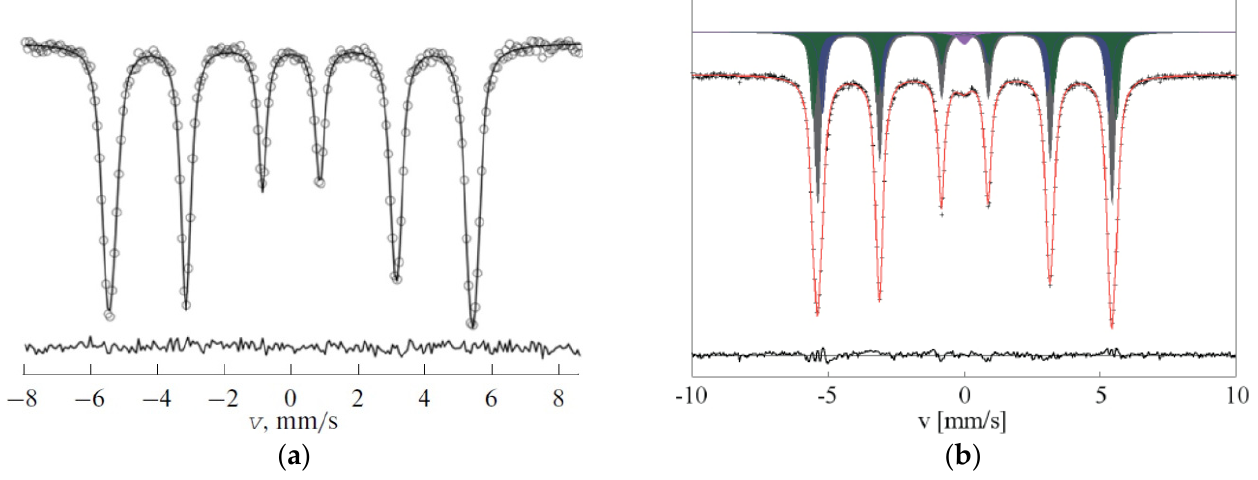
Figure 29. Comparison of the room temperature Mössbauer spectra of Sikhote-Alin IIAB measured in [78] ( a ) and in [79] ( b ). Indicated spectral components are the results of the fits. The differential spectra are shown on the bottom. Adapted from [78,79].